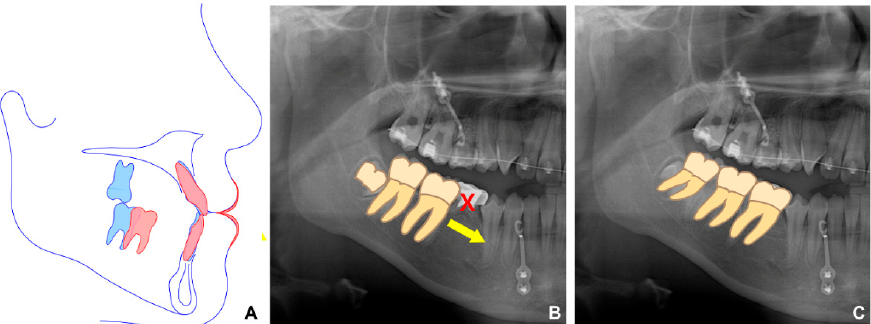
Figure 4. Schematic diagram related to protraction of the mandibular right posterior teeth. ( A ) Virtual treatment objective image. Blue and red lines are before and after treatment, respectively. ( B ) The protraction of the mandibular right first and second molars to the position where the right primary second molar was extracted. The yellow arrow represents the direction of tooth movement. X indicates extracted tooth. ( C ) Eruption of the mandibular third molar to the natural occlusal plane because of the anterior movement of the mandibular right molars.